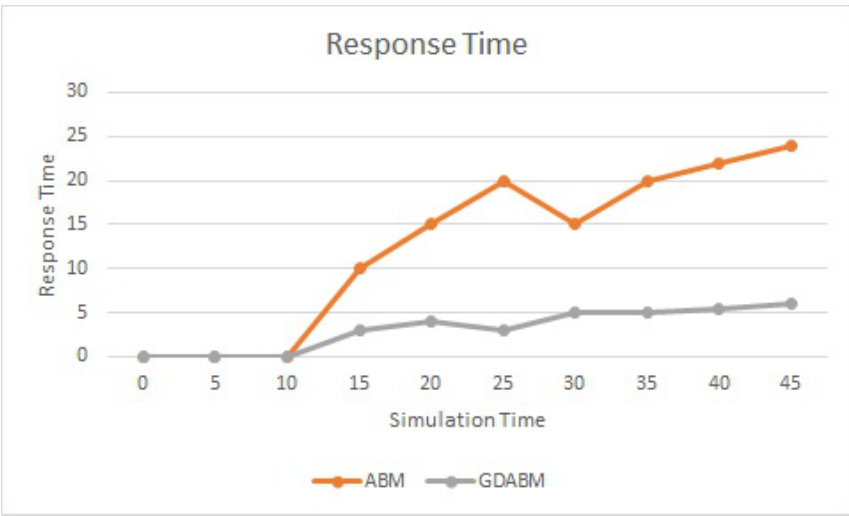
Figure 21. Comparison of the response times for both ABM and